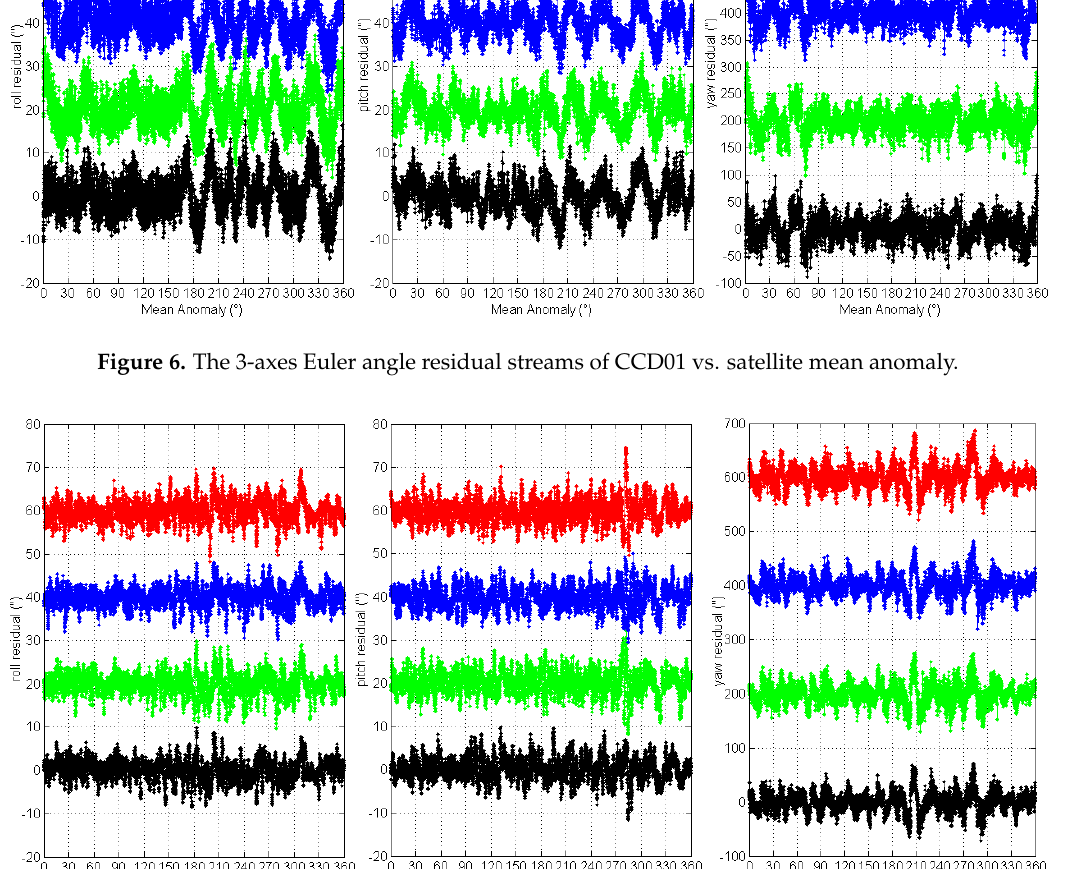
Figure 7. The 3-axes Euler angle residual streams of APS01 vs. satellite mean anomaly.